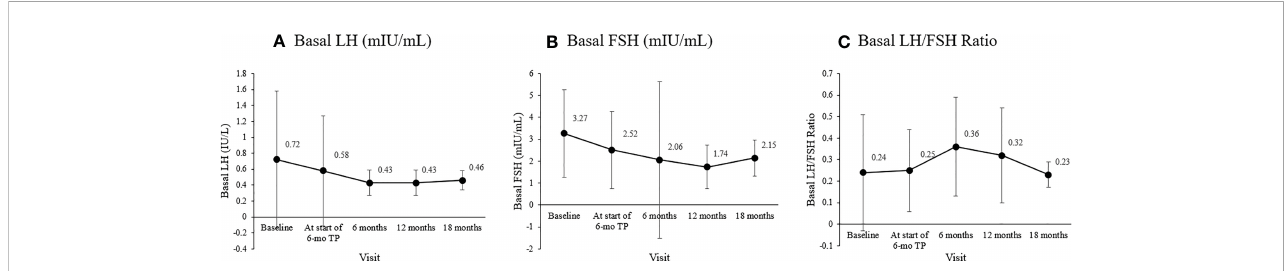
FIGURE 4 Changes in the mean basal gonadotropin levels during treatment. (A) Basal luteinizing hormone (LH; mIU/mL; overall p = 0.109). (B) Basal follicle- stimulating hormone (FSH; mIU/mL; overall p = 0.049). (C) Basal LH/FSH ratio (overall p =